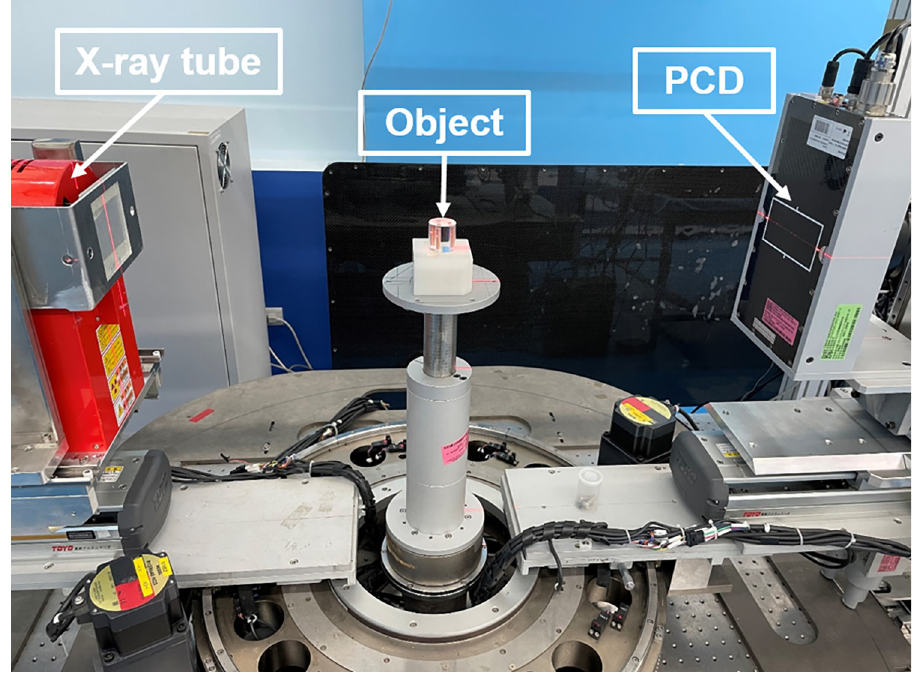
Fig 3. Image of the spectral micro-CT prototype system with